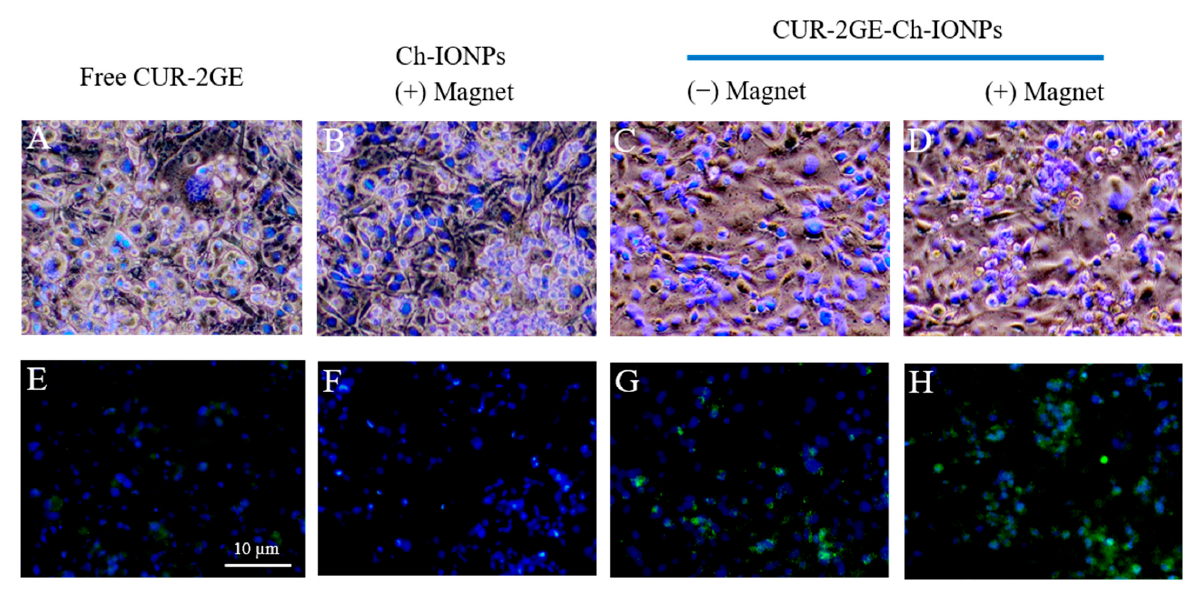
Figure 12. Cellular uptake showing the microscopic images of MDA-MB-231 after incubation with ( A , E ) free CUR-2GE, ( B , F ) Ch-IONPs, ( C , G ) CUR-2GE-Ch-IONPs in the absence of the permanent magnets, and ( D , H ) CUR-2GE-Ch-IONPs in the presence of the permanent magnets. There were sparse green fluorescence intensity signals from the free CUR-2GE due to its hydrophobic nature and possible aggregation within the extracellular spaces. The absence of green fluorescence signals with Ch-IONPs signifies that the green fluorescence signals were from the CUR-2GE. The occurrence of the green fluorescence signals of CUR- 2GE from the CUR-2GE-Ch-IONPs in the absence of the permanent magnets can be at-